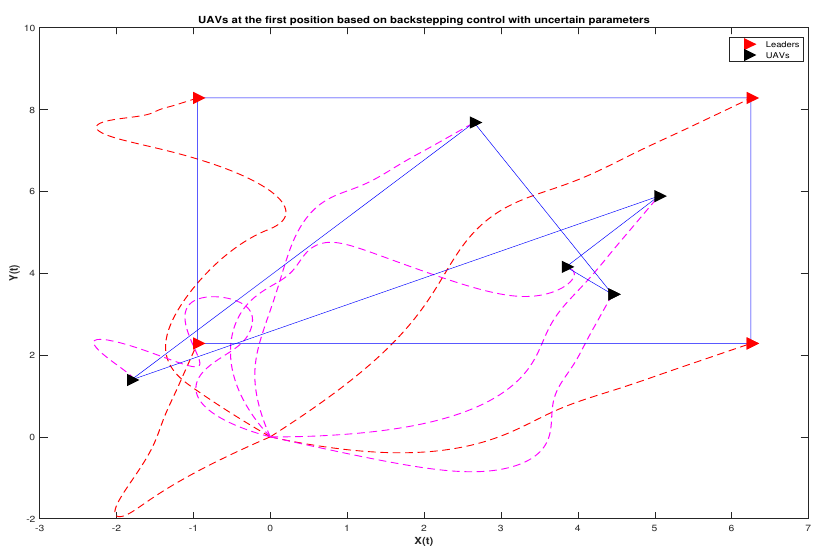
Figure 11. UAVs containment at the first position based on backstepping control with parameters uncertain.